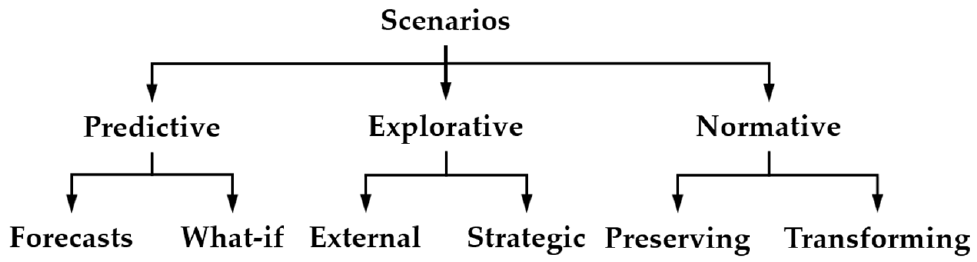
Figure 1. Scenario typology.